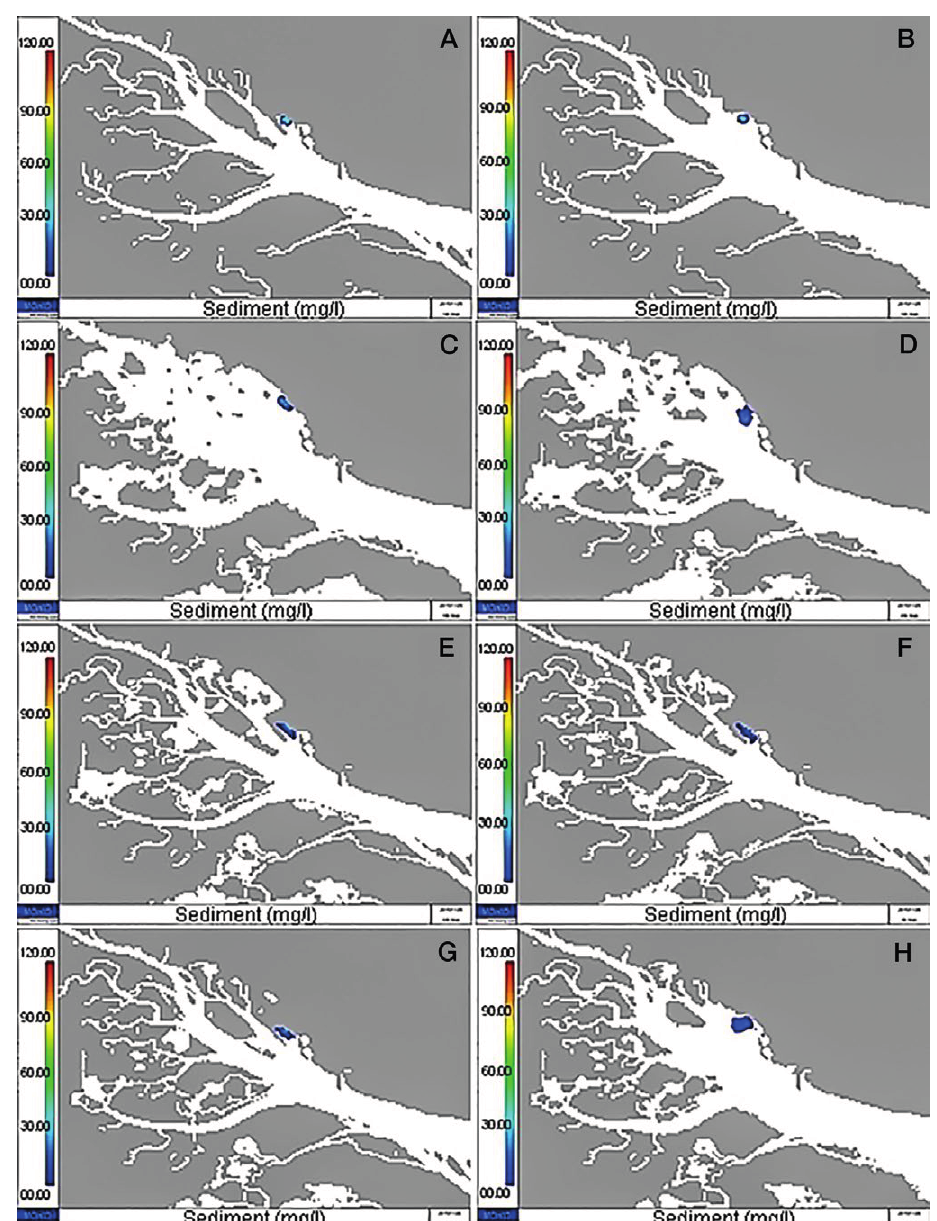
Fig. 10. – Biosediment suspended in the water column at Villa del Mar. A, 14 hs; B, 16 hs; C, 18 hs; D, 20 hs; E, 22 hs on 25-11-2015; and F, 00 hs; G, 02 hs; H, 04 hs on